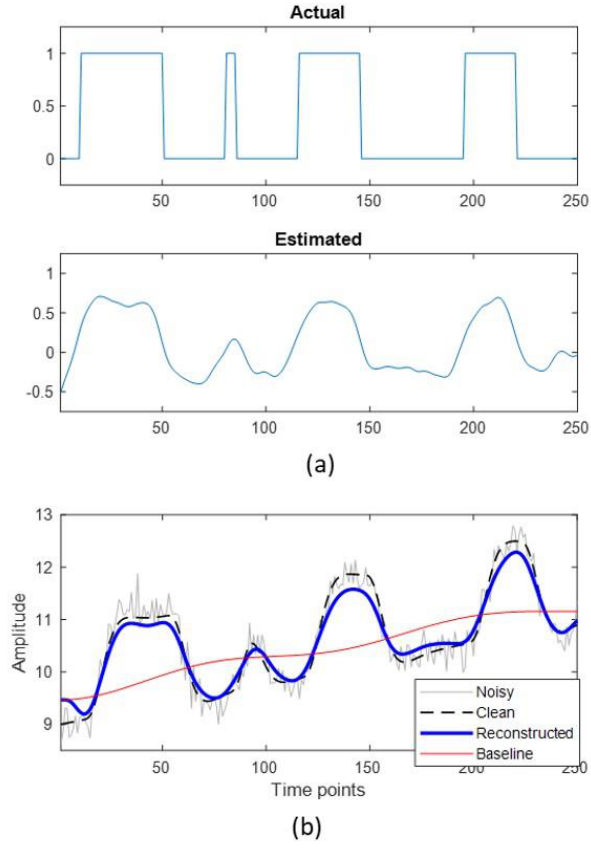
Figure 3. ( a ) The actual ( top ) and the estimated ( bottom ) stimulus for a synthetic time series data. ( b ) synthetic time series. Noisy time series was obtained by adding gaussian noise and signal drift to the clean time series. The noisy time series was used as input for the proposed approach to obtain the estimated time series and estimated signal drift (baseline).